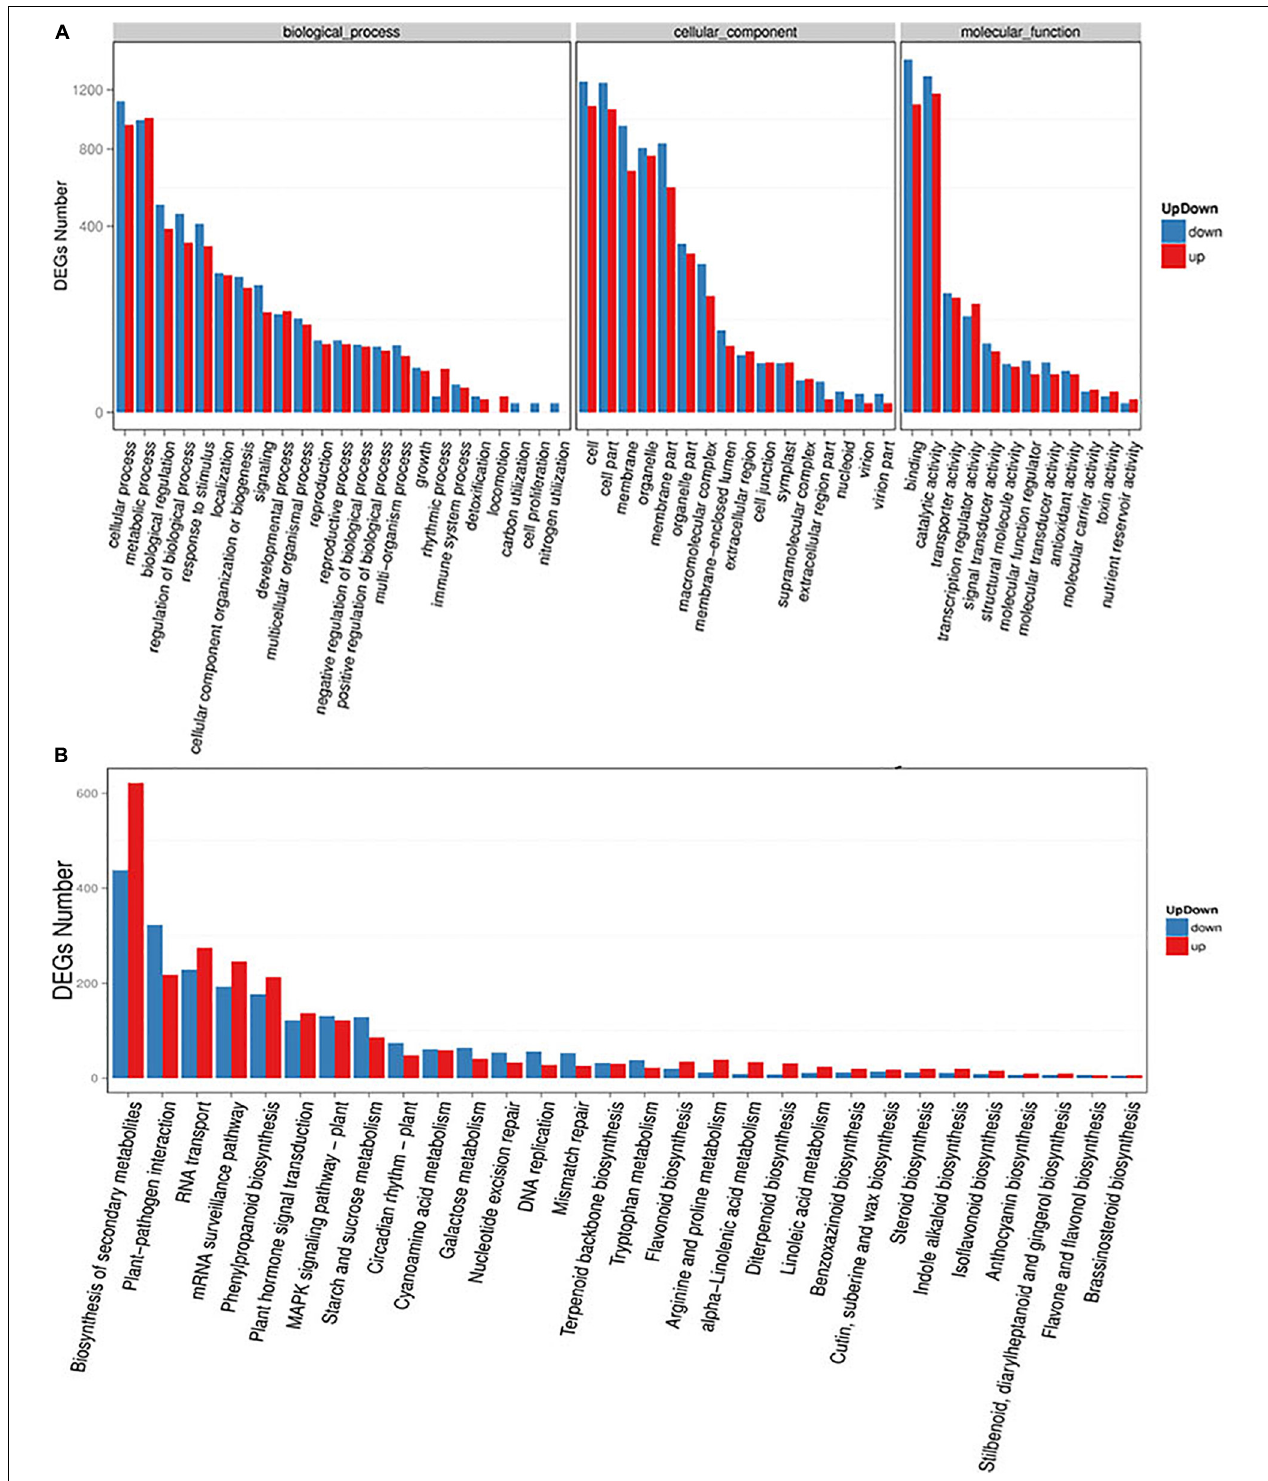
FIGURE 5 | Functional annotation of assembled transcriptome. (A) Gene ontology (GO) classifications of the annotated DEGs (up- and down-regulated). (B) Kyoto Encyclopedia of Genetics and Genomics (KEGG) database analyses of DEGs (up- and down-regulated) enriched in different biological pathways. The X -axis represented enriched pathways and Y -axis represented the total number of